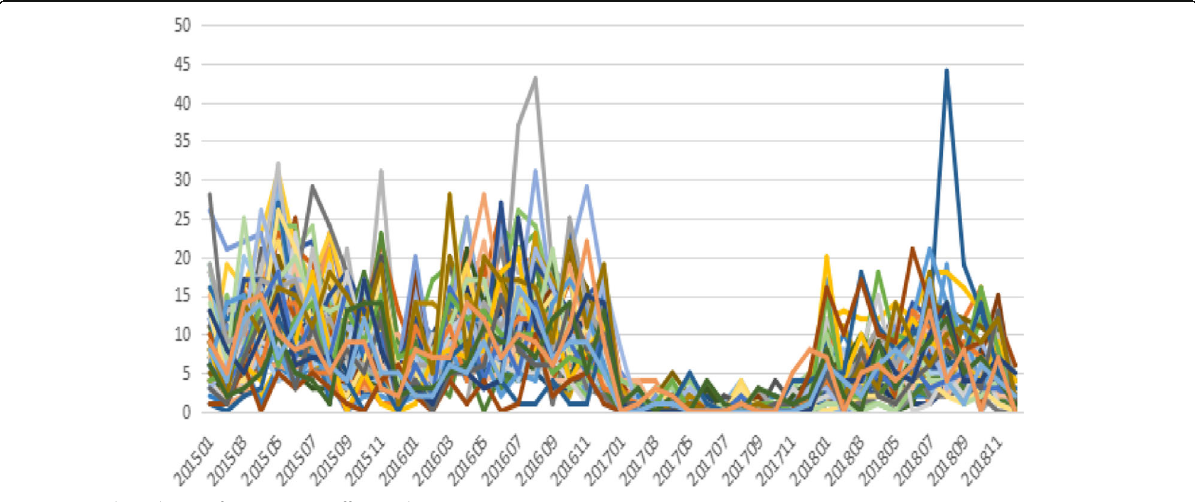
Fig. 5 Spatial incidence of category 3 traffic